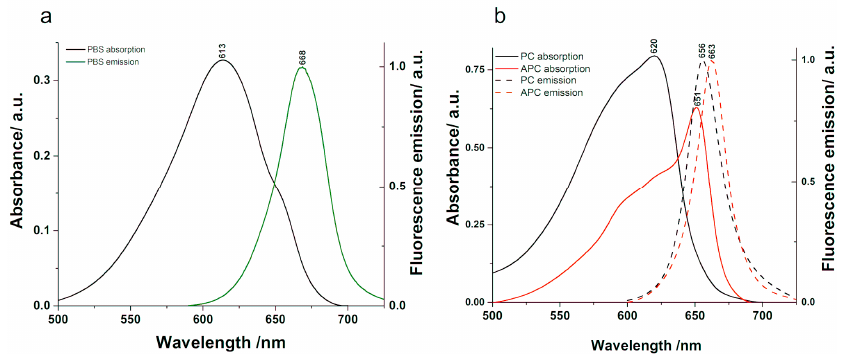
Figure 2. Ground-state absorption and fluorescence emission (excitation 580 nm) spectra characteristic to the phycobilisome ( a ) and to the isolated phycocyanin and allophycocyanin, respectively ( b ).